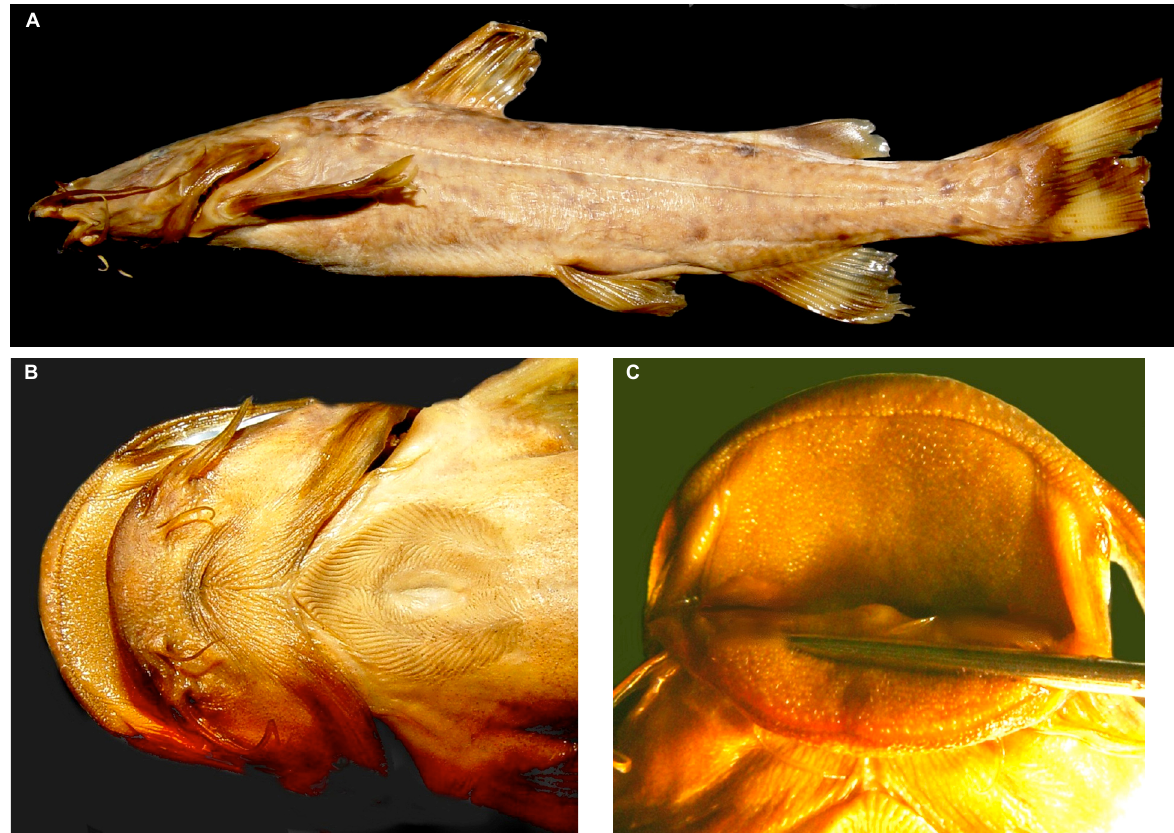
Image 1. Glyptothorax burmanicus , ZSI F10877/1, holotype, 100.8mm SL, Burma: Sankha. A - lateral, B - thoracic adhesive apparatus, C - tooth band